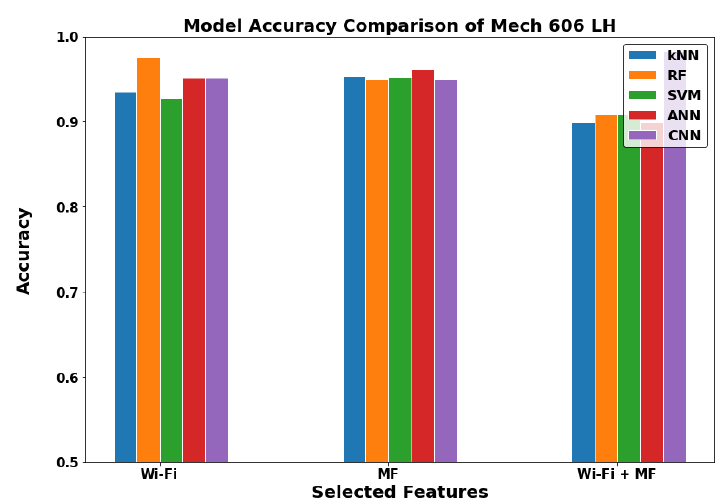
Figure 13. The models comparison in Mech 606 LH (Indoor).